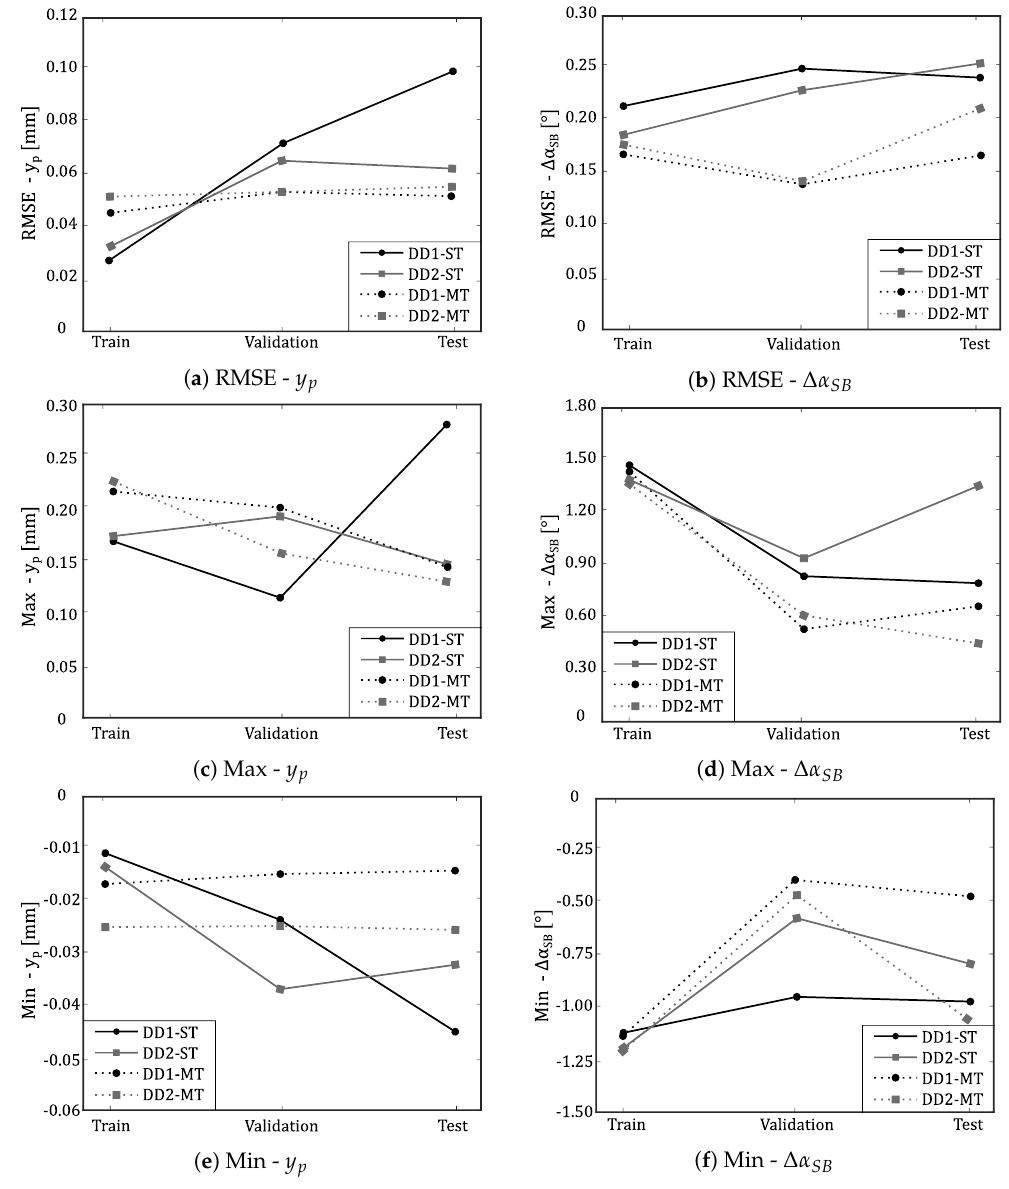
Figure 16. Performance measures of neural networks for the two different data sets (DD1 and DD2) and considering both single (ST) and multitask (MT) ANN structure; all performance measures are presented for the train, validation and test data sets; ( a ) punch displacement ( y p ) RMSE value; ( b ) springback angle ( ∆ α SB ) RMSE value; ( c ) punch displacement ( y p ) maximum value; ( d ) springback angle ( ∆ α SB ) maximum value; ( e ) punch displacement ( y p ) minimum value; ( f ) springback angle ( ∆ α SB ) minimum